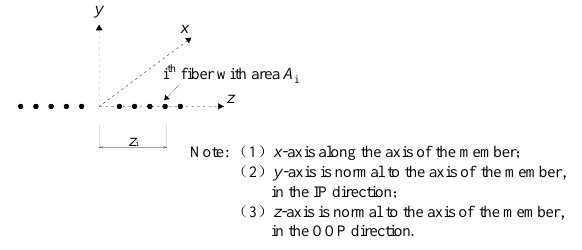
Figure 10. Fiber discretization of beam–column elements [10].